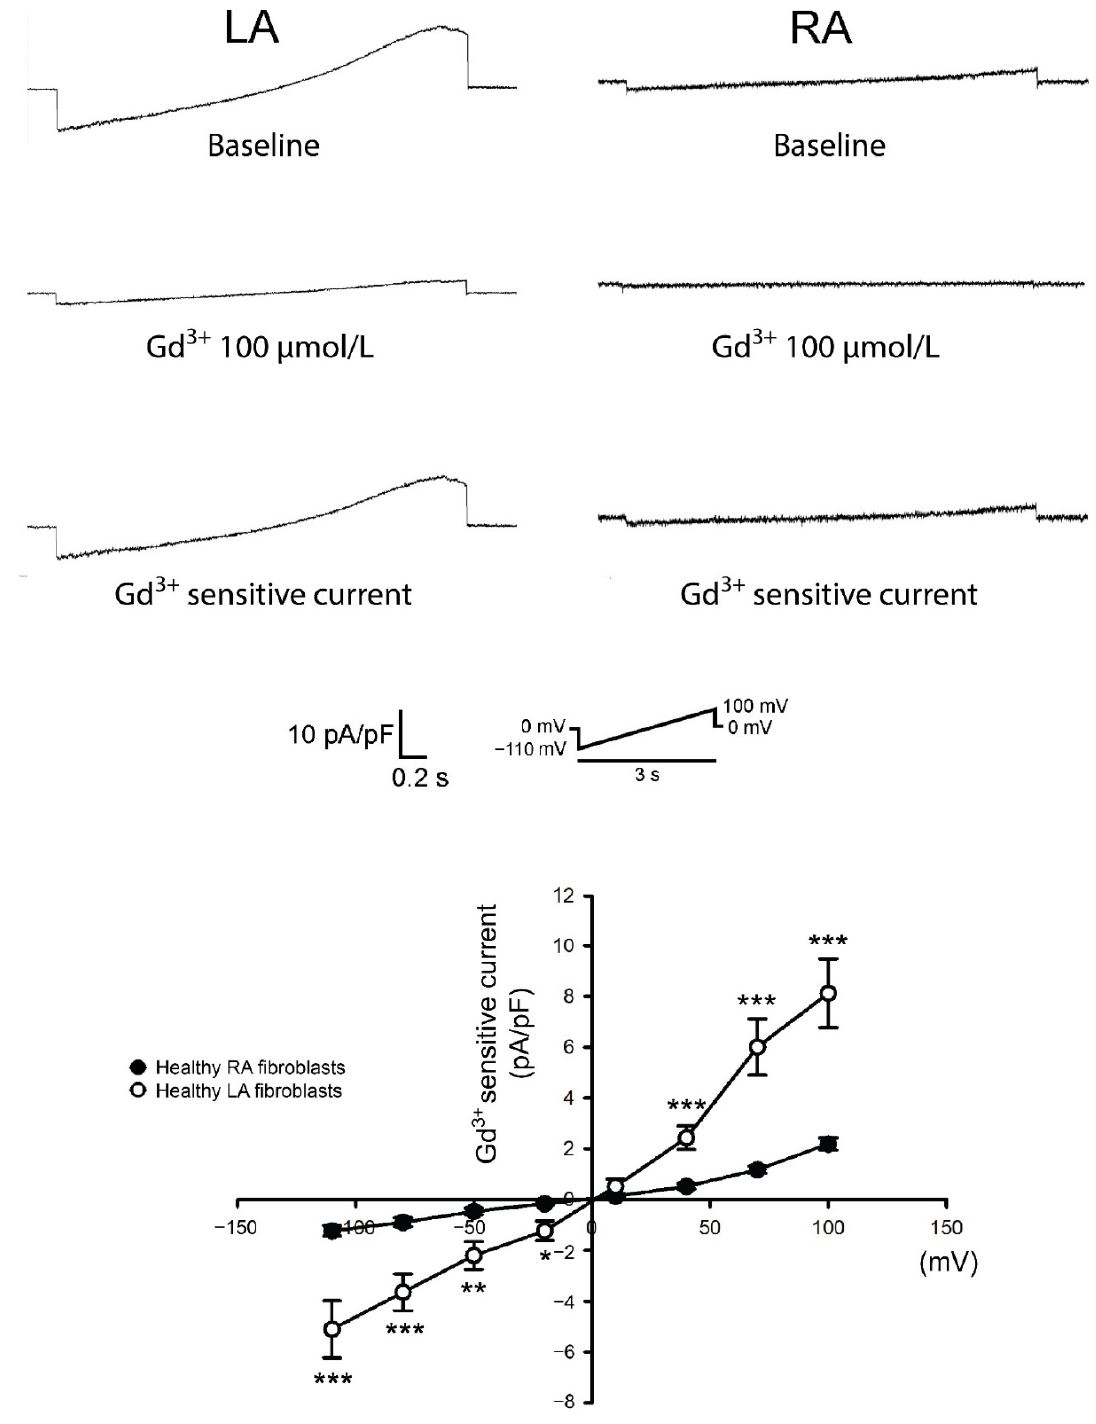
Figure 2. Membrane gadolinium (Gd 3+ )-sensitive currents in isolated passage 0 (P0) left atrium (LA) and right atrium (RA) fibroblasts from healthy rats. Left panels reveal tracings of the Gd 3+ (100 μ mol/L)-sensitive non-selective cation current from LA fibroblasts (n = 10 from five rats) and RA fibroblasts (n = 10 from five rats). Right panels reveal the current/voltage (I/V) relationship of the Gd 3+ -sensitive non-selective cation current. * p < 0.05, ** p < 0.01, *** p < 0.005. The insets in the current traces show the various clamp protocols .